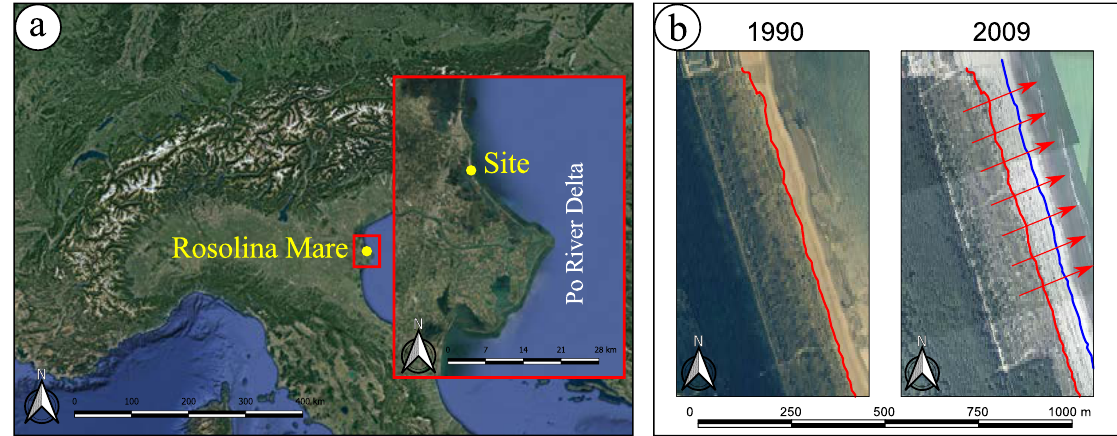
Figure 1. ( a ) The case study location, northern Italy (by Google Earth); ( b ) The progression ( progradation ) of the embryo dunes’ limit over 19 years in the